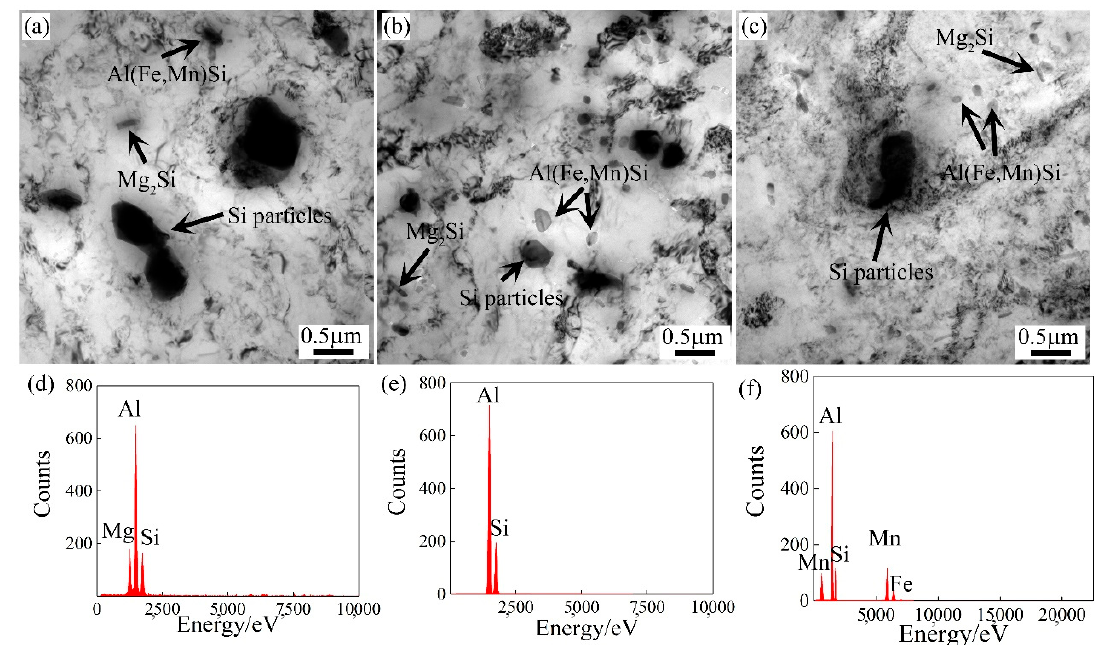
Figure 4. TEM images and EDS analysis of the second particles’ distribution in the cold-rolled alloy sheets: ( a , d ) A1 alloy, ( b , e ) A2 alloy, and ( c , f ) A3 alloy.